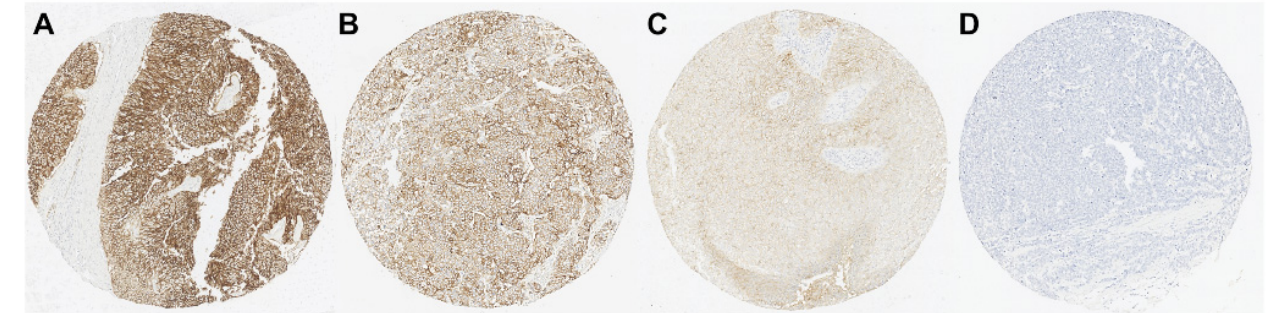
Figure 1. Immunohistochemical expression of trophoblast cell surface antigen 2 (Trop-2) in upper tract urothelial carcinoma (UTUC) tissue microarray specimens. UTUC tissue with ( A ) high (3+), ( B ) moderate (2+), ( C ) low (1+), and ( D ) negative (0+) expression. 3.3. Immunohistochemical Analysis of Associations of Trop-2 Expression with Patient Outcomes The Kaplan–Meier analysis of the prognostic value of Trop-2 expression status in Table 2. Association of Trop-2 expression with clinicopathological characteristics of upper tract UTUC revealed that patients with high Trop-2 expression ( n = 27) had a significantly lower risk of tumor progression (Log-rank test, p = 0.0011; Figure 2A) or cancer-specific urothelial carcinoma. mortality (Log-rank test, p = 0.0046; Figure 2B) than those with moderate, low, or nega- tive Trop-2 tumor expression ( n = 72). In a sub-group of patients with muscle-invasive tumors ( n = 62), high Trop-2 expression was also associated with favorable PFS ( p = 0.032, Supplementary Figure S1A) and cancer-specific survival ( p = 0.061, Supplementary Figure S1B).